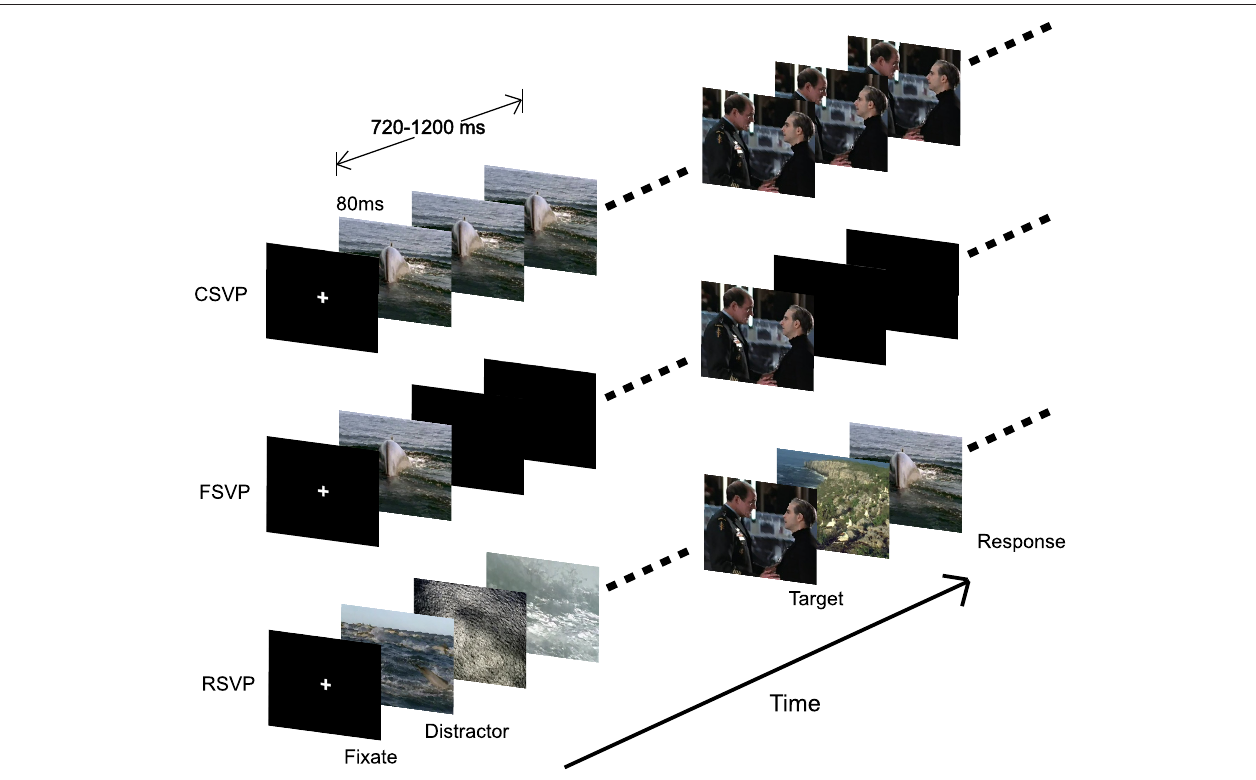
FIGURE 1 | Schematic representation of each type of sequence used in this study. Each image represents two successive frames (80 ms in duration). For each type of sequence, subjects fi rst fi xated on the center of the screen and were subsequently presented distractor or target clips. They were instructed to make a button response when they detected a